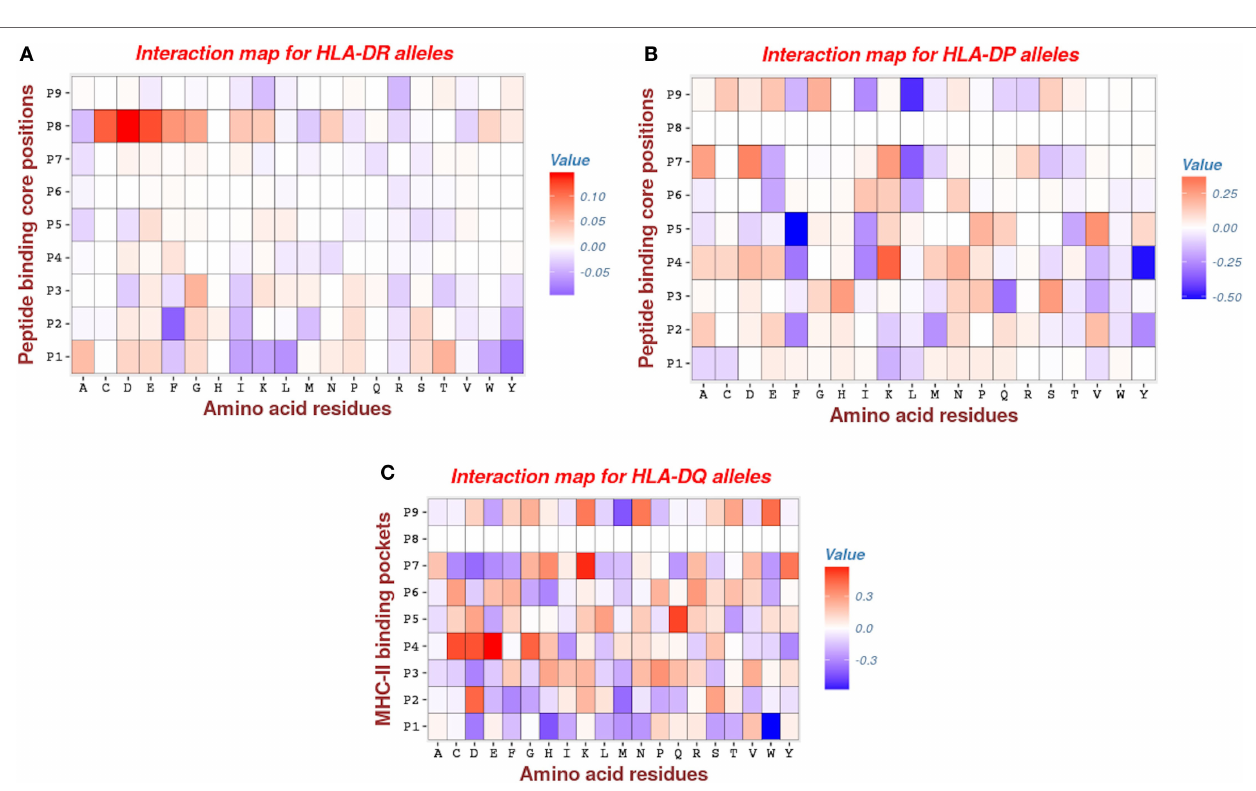
FIGURE 5 | Interaction maps for: (A) HLA-DR, (B) HLA-DP, and (C) HLA-DQ molecules. The rows give the 9 anchor positions of MHC-II binding groove and the columns give the peptide residues. The red entries marking for repulsive interactions (positive energy), whereas the blue entries marking for attractive interactions (negative energy). Note that most of the entries are zeros (white color), an indication for the degree of the sparsity of the model.